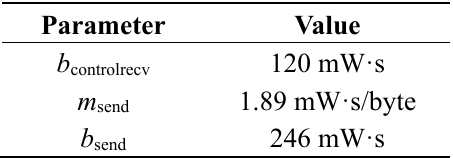
Table 4. Constants used in the calculation of power